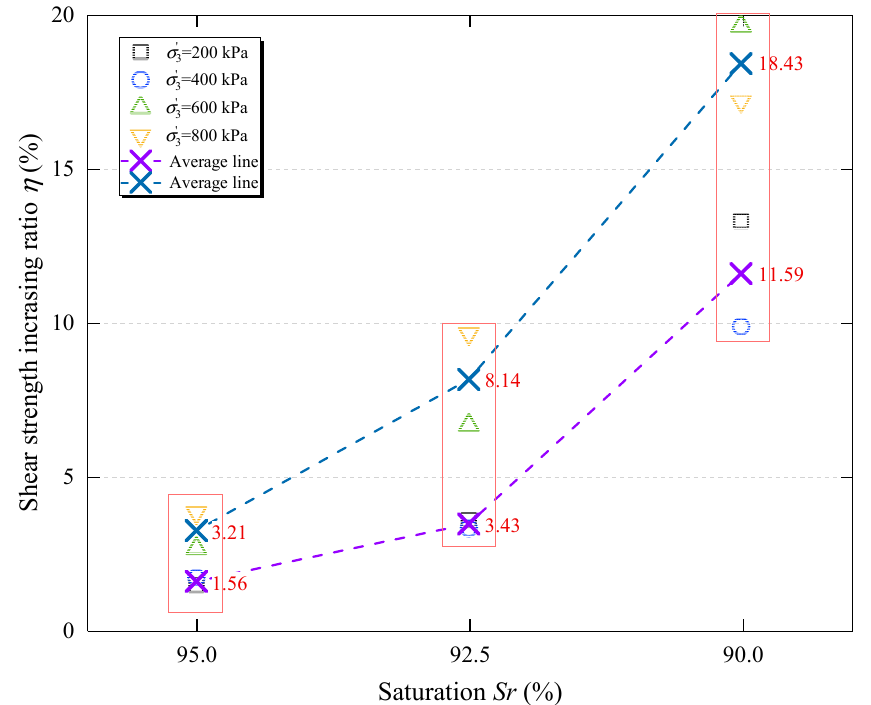
Figure 22. Relationship between shear strength increasing ratio and saturation of coral sand.